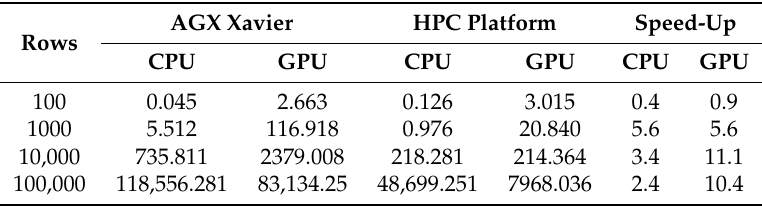
Table 4. Comparison of the execution time (in seconds) of the GPU and CPU implementations of the FM algorithm between the HPC and edge computing platforms. AGX Xavier HPC Platform Speed-Up Rows CPU